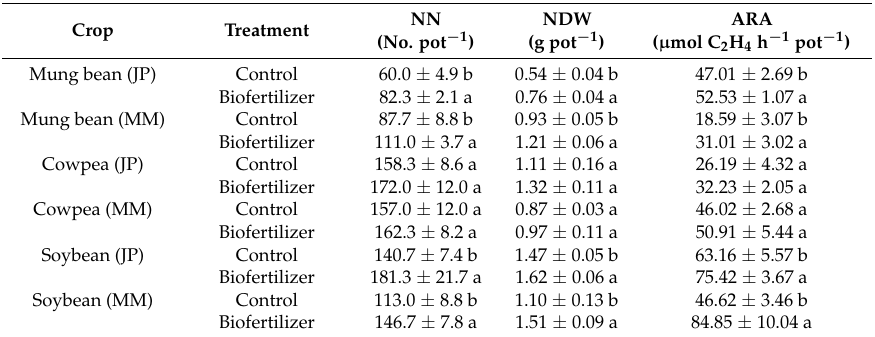
Table 6. Effect of biofertilizer on NN, NDW and ARA of mung beans, cowpeas and soybeans at R3.5 (early pod-fill stage).